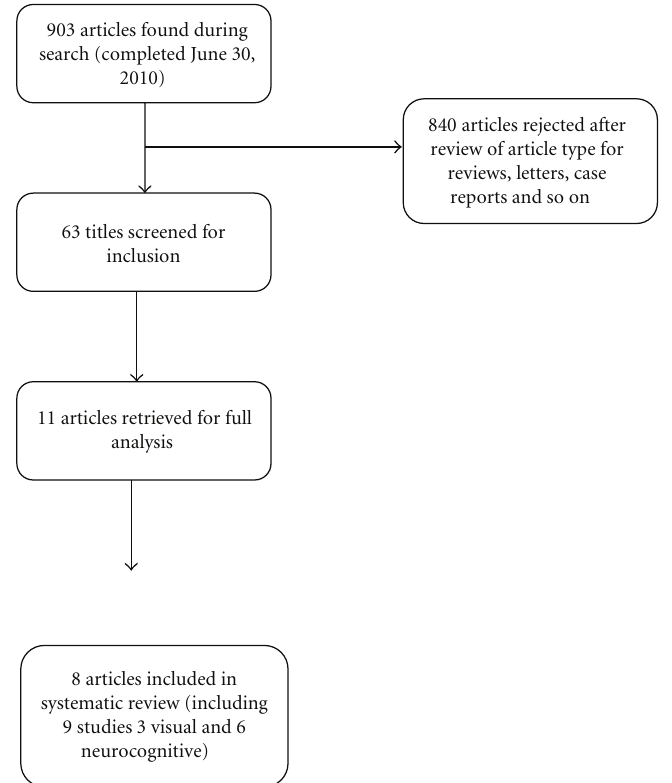
Figure 1: Search strategy flow